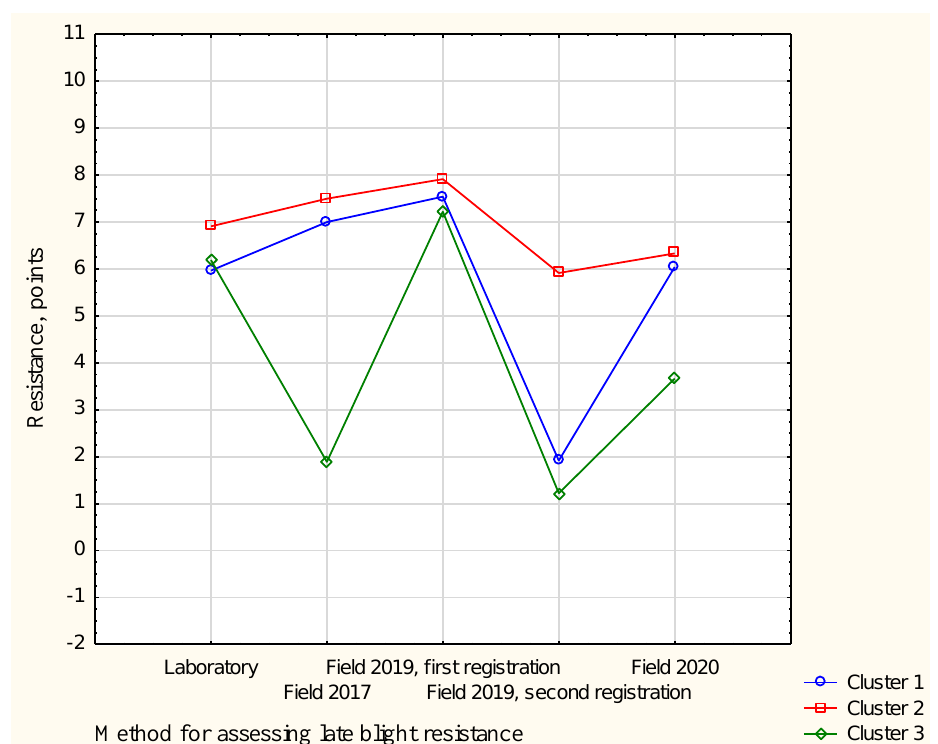
Figure 4. F1 progeny clustering by the k-means method regarding LB resistance. The three clusters resulting from each classification method application were similar in composition. Cluster 2 contains 12 F1 clones that were most resistant to LB in the field experiments and in the laboratory tests; on an average, this group scored 5.9 – 7.9 points (Figure 4). Cluster 1 comprises 24 F1 clones, with significant leaf damage registered dur- ing the second survey in the field experiment of 2019; the average score of this group was 1.9 – 7.5 points. Cluster 3 includes 9 F1 clones most affected by LB in the field in 2017, 2019 (second survey) and in 2020; the average score of this group was 1.2 – 7.2 points (Figure 4). 3.3. Rpi Genes in Parents and F1 Progenies Both parents and 60 F1 progenies were screened with SCAR markers that were de- veloped to track nine Rpi genes . Both parents and segregants were devoid of the markers for Rpi-R1, Rpi-blb2 and Rpi-blb3 genes. Two parents seemed to comprise the Rpi-R3b , Rpi- blb1 / Rpi-sto1 genes and differed as regards the Rpi-R2, Rpi-R3a and Rpi-vnt1.3 genes. While the markers Rpi-R2-1137, Rpi-R2-686 and Rpi-blb3-305 correspond to close orthologue and usually manifest perfect agreement, here the latter marker was absent from the gen- otypes under study, and poor match was observed in the case of two former markers (Ta- ble S1. SCAR markers of Rpi -genes in F1 progeny and parental lines). The profile of SCAR markers in cv. Sudarynya is in good agreement with the evi- dence by Gavrilenko et al. [8] who reported in this genotype the markers of Rpi-blb1 / Rpi- sto1 and Rpi-R3a genes. The pedigree of the hybrid 13/11-09 has not been clearly established; reportedly it lists S. andigenum, S. berthaultii, S. demissum, S. microdontum, S. polytrichum, S. pinnatisectum and S.×vallis-mexici . Therefore, it was important that this genotype was also analyzed us- ing the dRenSeq technology, which reliably discerns the full-length gene sequences from non-functional homolgos. In this case, only two genes were identified in this hybrid: Rpi- R3b and Rpi-blb1-like (Figure 5). The Rpi-R3b sequence found in these plants was 99.95%